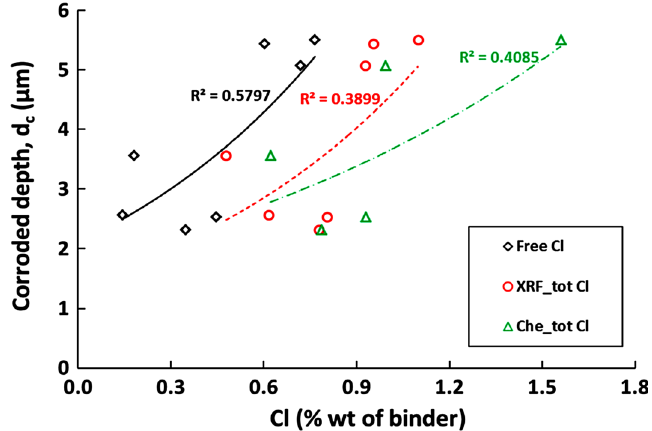
Fig. 17 Relationship between corroded depths and different chloride content.